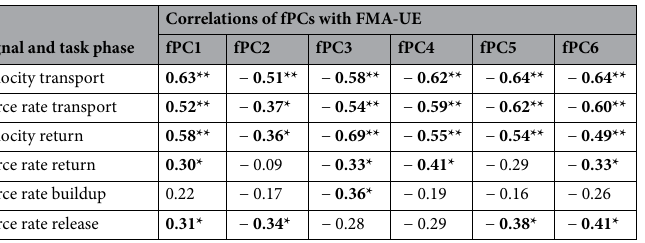
Table 1. Correlations between the variance explained per fPC and the FMA-UE. The Spearman correlation analysis was performed for the paretic of post-stroke subjects. Bold indicates significant entries. * P < 0.05. ** P <